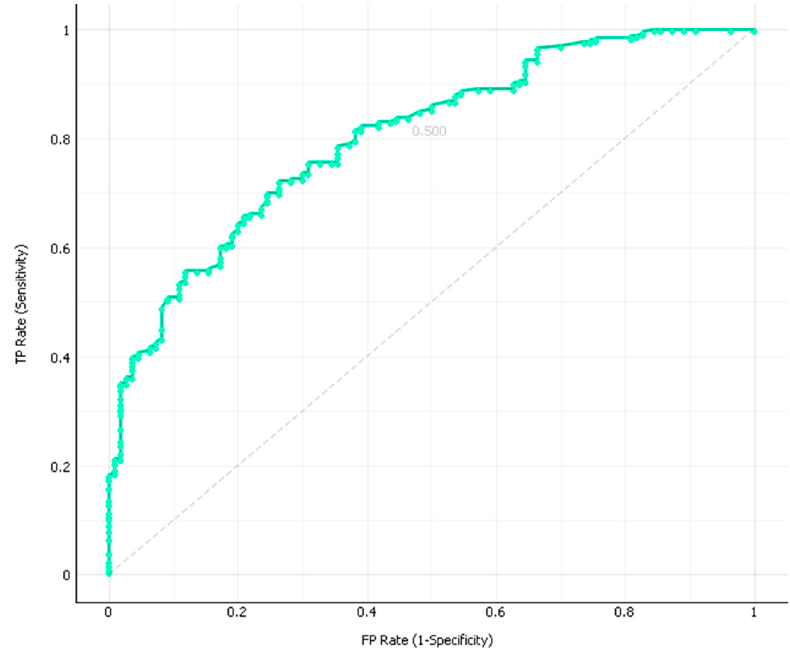
Figure 4. Roc curve after 10-fold cross validation of T18 Bayesian network.